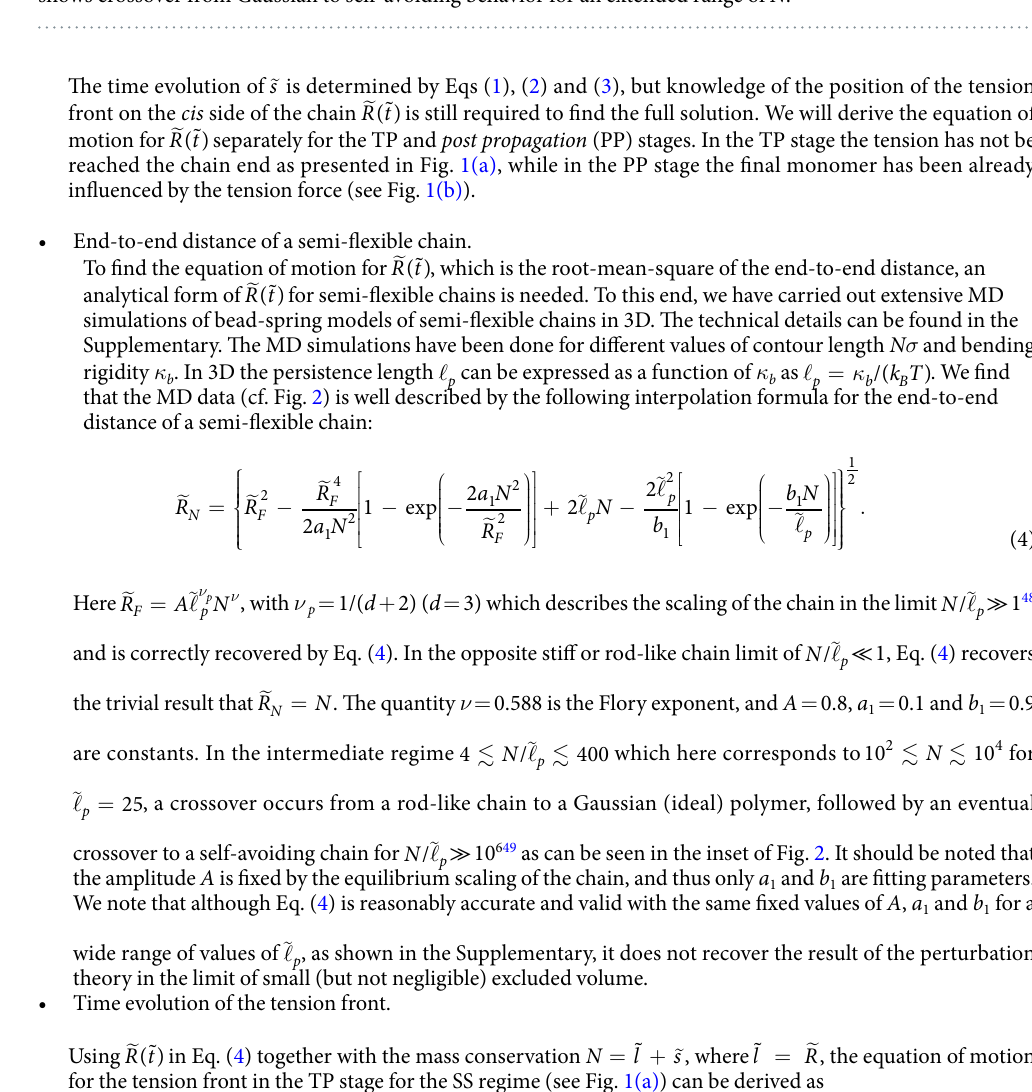
2 2 as a function of the contour length of the polymer N for Figure 2. Normalized end-to-end distance ν  R N / N fixed value of bending rigidity (in the MD simulations) κ b = 30, which corresponds to =  25 , when k B T = 1.2. p The black curve shows the analytical formula of Eq. (4) while red dots present the MD simulations results. Inset shows crossover from Gaussian to self-avoiding behavior for an extended range of N